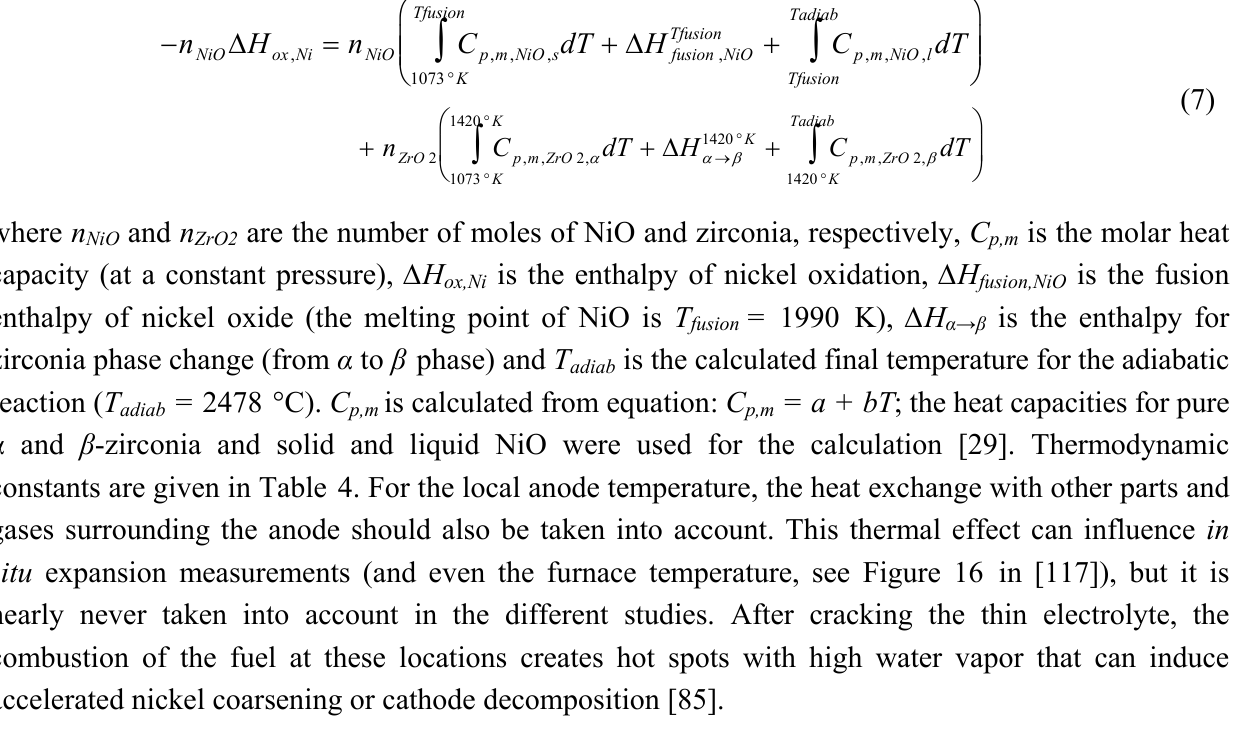
Figure 16. Dilatometry measurements of oxidation for a YSZ composite bar infiltrated with 16 wt % Ni